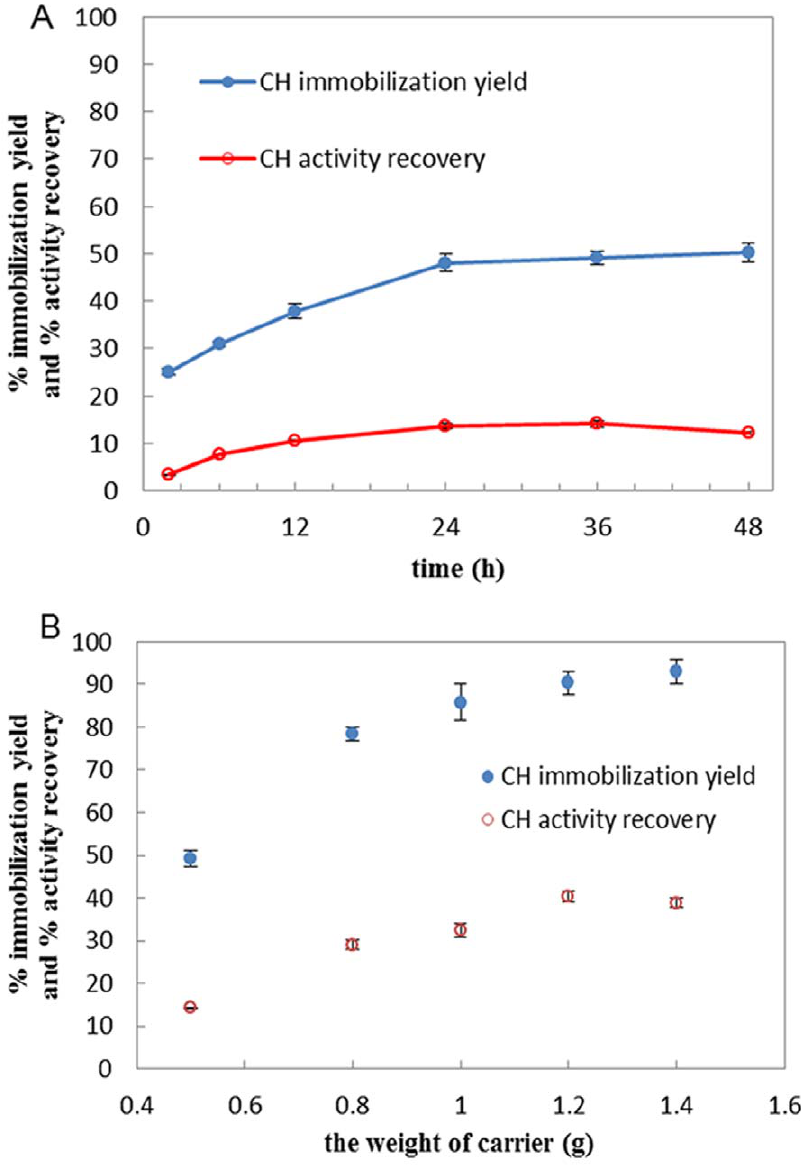
Figure 3. In situ immobilization of papain on chitosan beads. (A) The immobilization course: the experiment was conducted by incubating 0.5 g chitosan beads in 5 ml enzyme solutions at 25 u C, 200 rpm. (B) Effect of chitosan beads input amount on immobilization: the experiment was conducted by incubating different weight of chitosan beads in 5 ml enzyme solutions at 25 u C, 200 rpm.